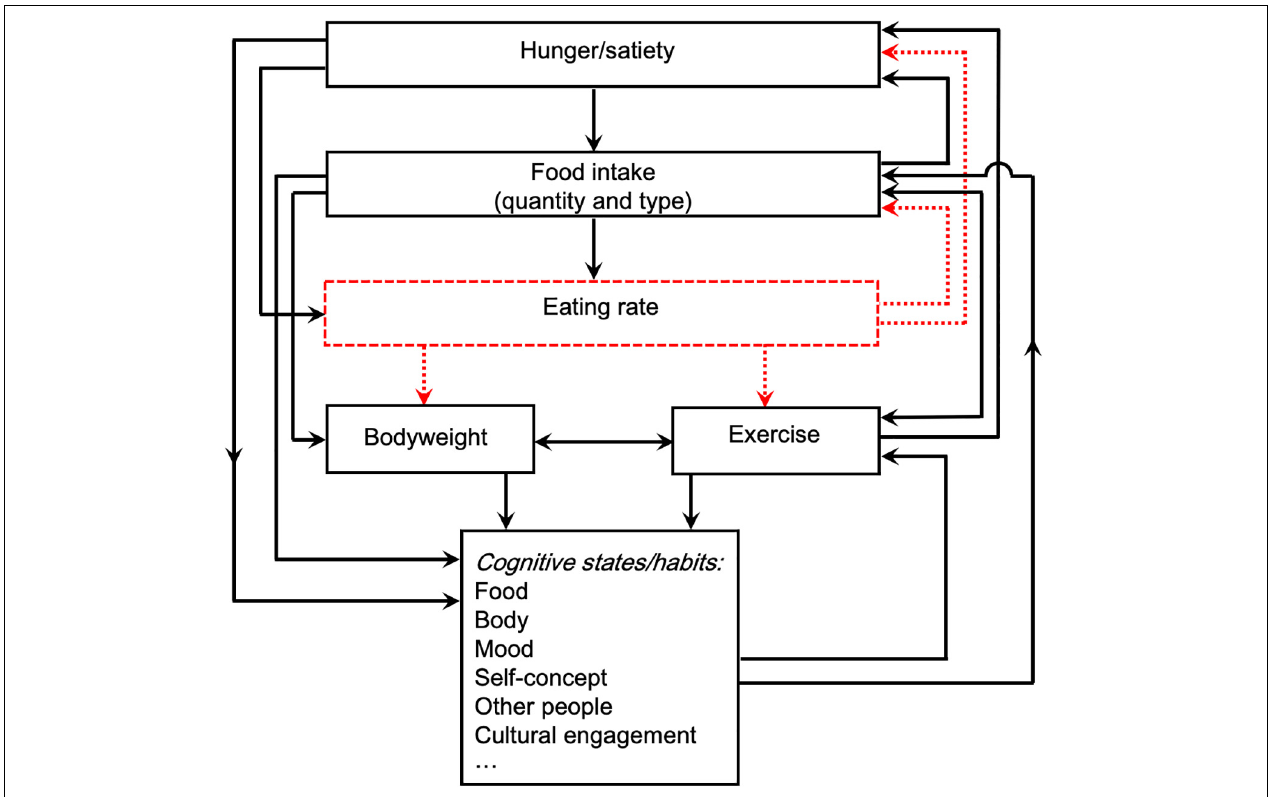
FIGURE 1 | Feedback interactions amongst cognitive, physiological, and behavioral components of the dynamics involved in eating. The red dotted box indicates the controller of the system, here eating rate, which provides an effective means of intervention in the feedback system, e.g., via the Mandometer device. The red dotted lines indicate the primary causal effects of controlling eating rate. Specific intermediary mechanisms (e.g., hormonal mediators) are omitted here for